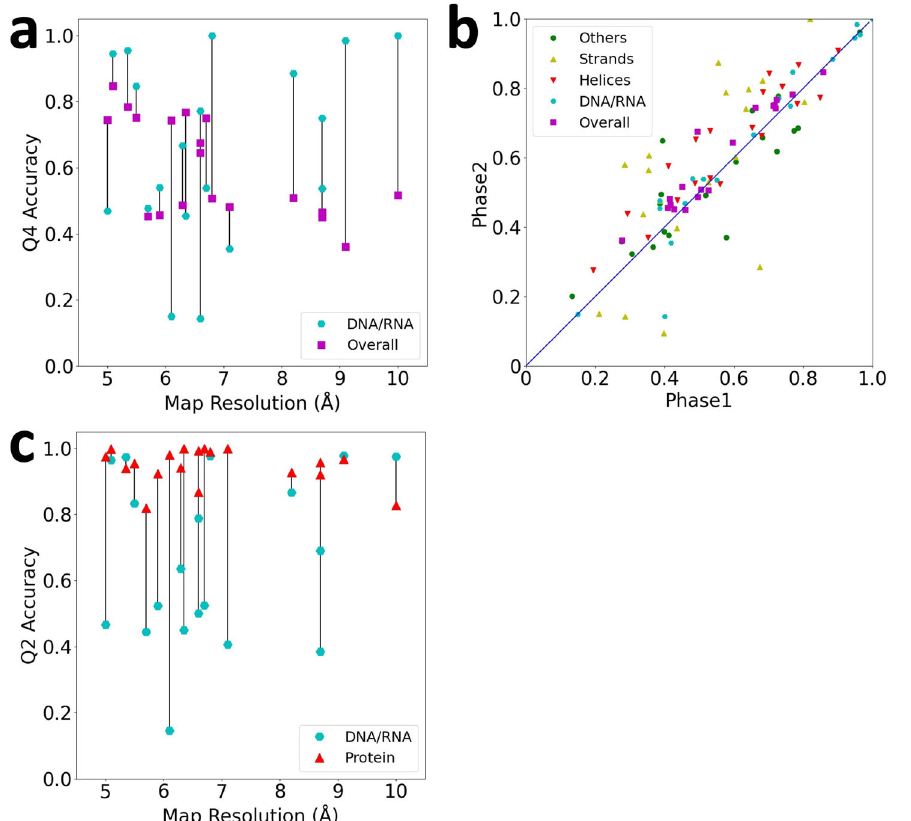
Fig. 4 Structure class detection on 19 experimental maps. See Supplementary Data 2 for the phase 1 and phase 2 accuracy of individual maps. a Q4 accuracy of experimental maps relative to the map resolution. Overall Q4 is shown in magenta squares and Q4 of DNA/RNA is shown in cyan circles. Lines connect values of the same map. b The residue-based accuracy comparison between the Phase 1 and Phase 2 networks. c Q2 binary classi fi cation accuracy for distinguishing the protein and DNA/RNA classes in experimental maps. Note that values for DNA/RNA can be different from panel a, which reports the results of four-class classi fi cation. Since the probability of the protein class was computed as the sum of probabilities of three secondary structure classes, a DNA/RNA assignment in the four-class classi fi cation can be changed to protein in the binary classi fi cation. Results of individual maps are provided in Supplementary Data